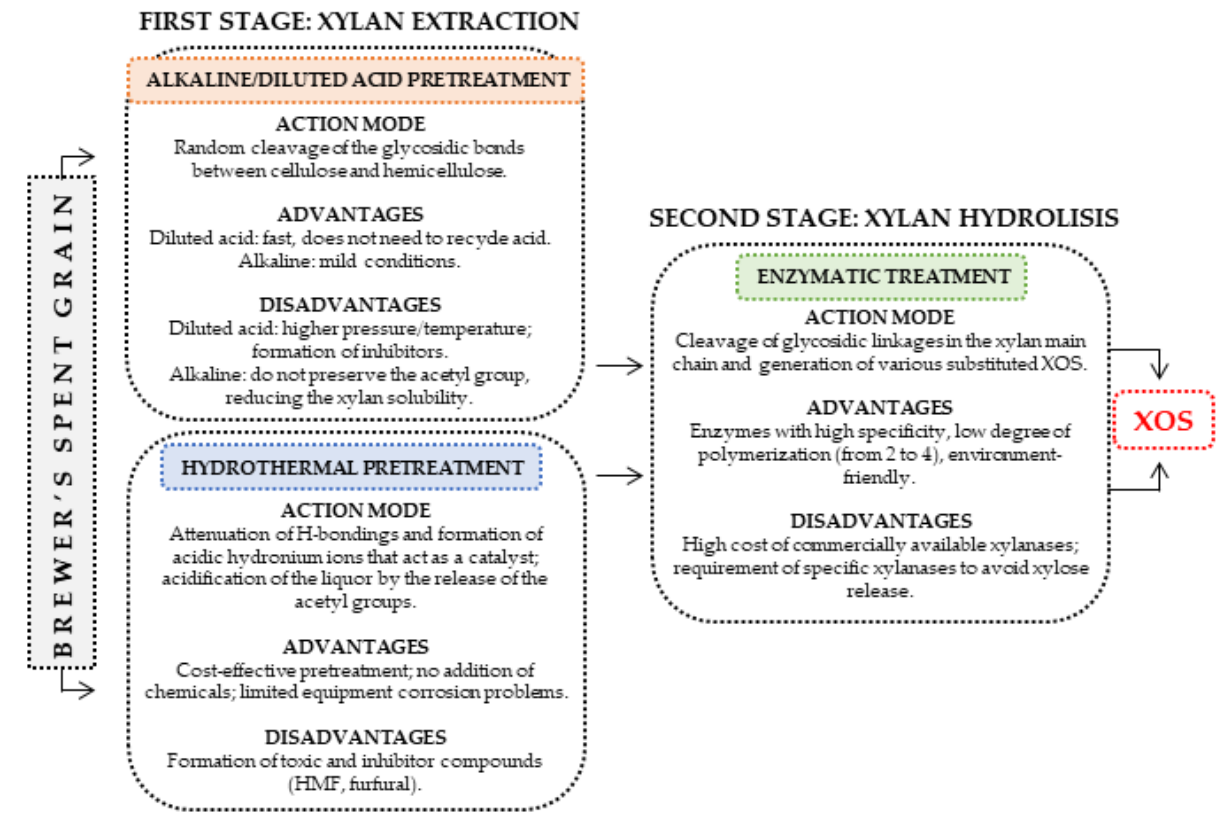
Figure 3. Pretreatments involved in XOS production at the first stage, and enzymatic hydrolysis at the second stage.